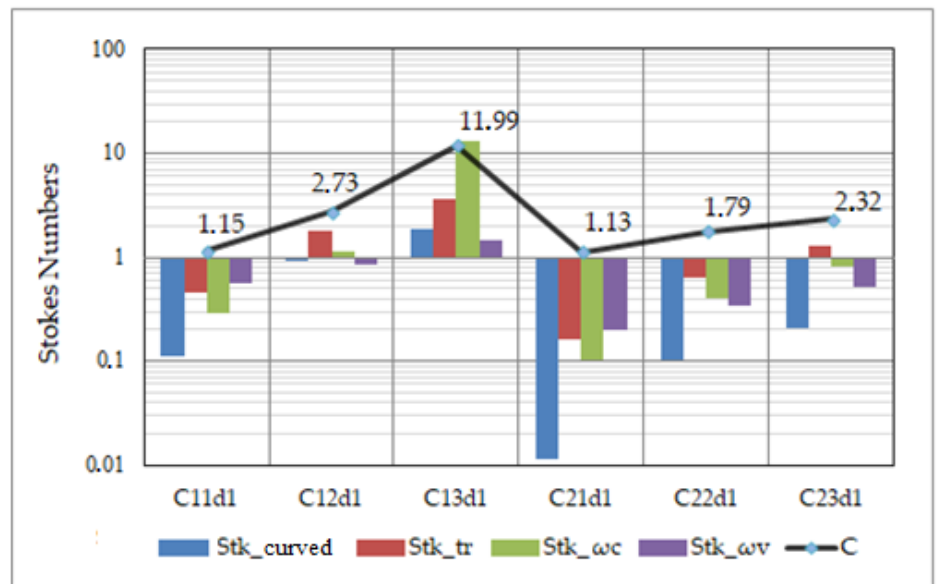
Figure 12. Bar graph of the Stokes numbers and trend line of relative concentrations between cases, for particle sizes d1 = 50 [μm].